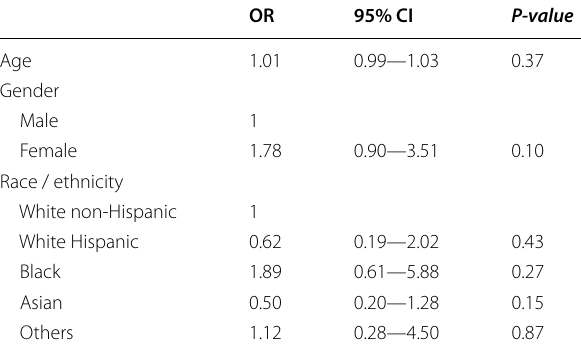
Table 5 Relationship between any ocular symptoms and age, gender, and